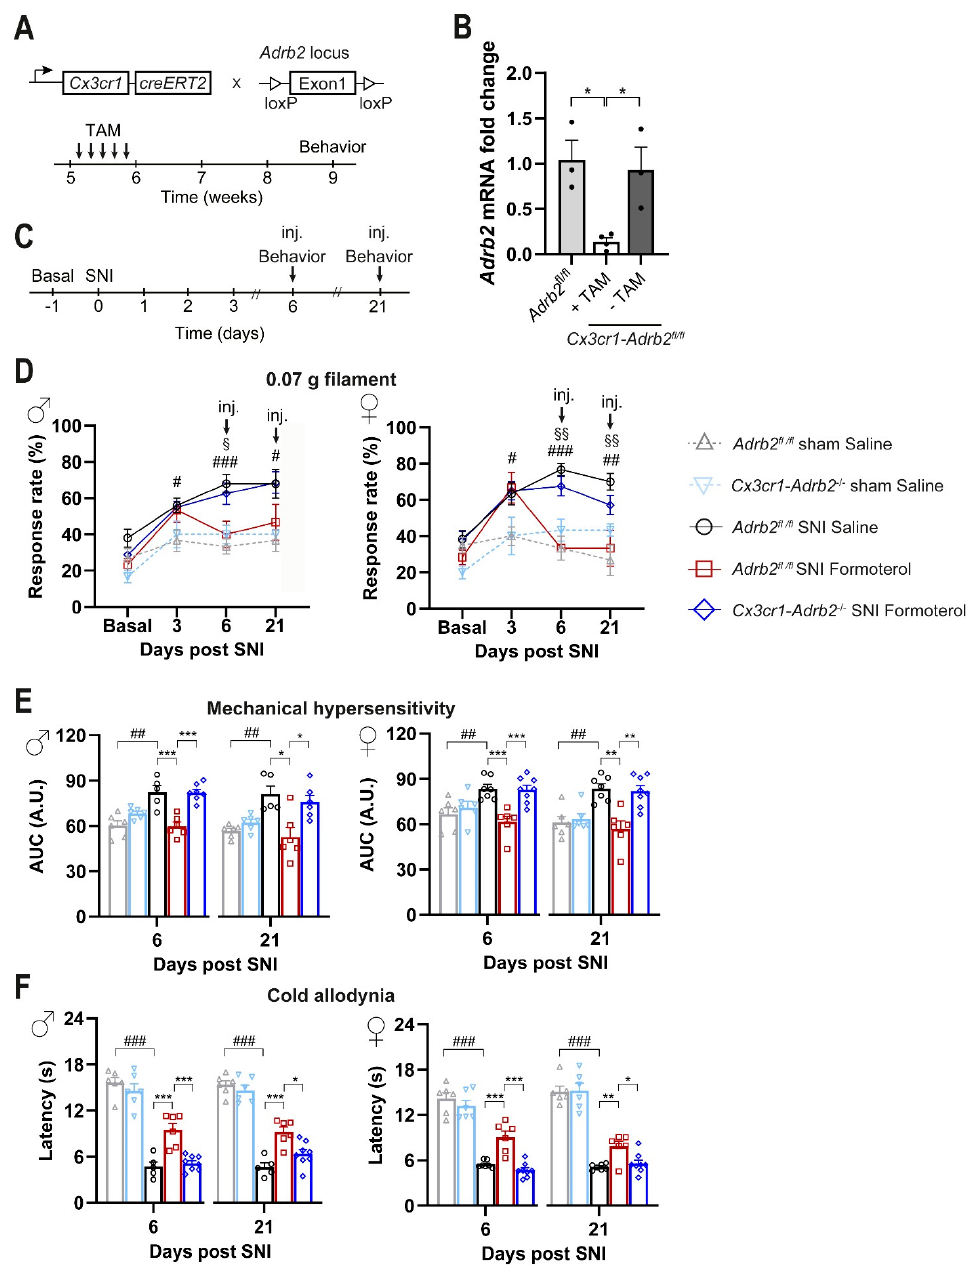
Figure 6. Effect of Formoterol on behavior in Cx3cr1-Adrb2 -/- operated mice. ( A ) Schematic representation of the strategy for generation of mice lacking the Adrb2 gene conditionally in microglial cells in a tamoxifen-inducible manner. ( B ) Analysis via qPCR demonstrating the loss of Adrb2 mRNA expression in microglia cells three weeks after tamoxifen injection in the mouse line Cx3cr1-Adrb2 fl / fl . The recombination does not occur in mice lacking the Cre-cassette ( Adrb2 fl/fl ). TAM